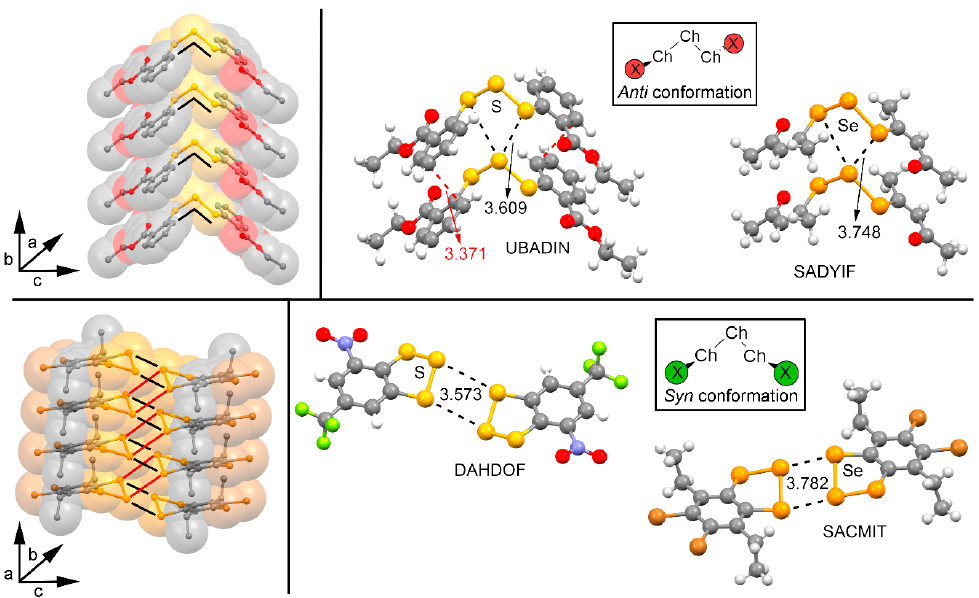
Figure 2. ( Left ) Structural patterns observed for anti ( top ) and syn ( bottom ) substituted S 3 /Se 3 compounds. ( Right ) Partial views of the X-ray structure of some anti ( top ) and syn ( bottom ) trisulphide and triselenide compounds exhibiting chalcogen ‘like-like’ interactions. The Cambridge Structural Database (CSD) codes are indicated. Distances in